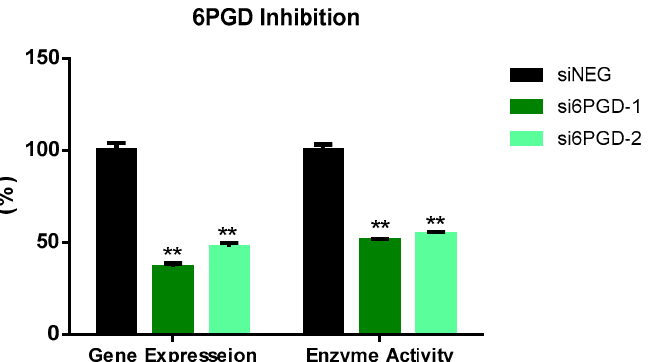
Figure 1. 6PGD mRNA expression 72 h after transfection with non-targeting siRNA (siNEG) or siRNAs against 6PGD. Fold change was calculated with respect to siNEG. 6PGD enzyme activity levels 96 h post-transfection using either siRNAs against 6PGD or non-targeting siRNA. Two asterisks (**) denote p -value < 0.01.